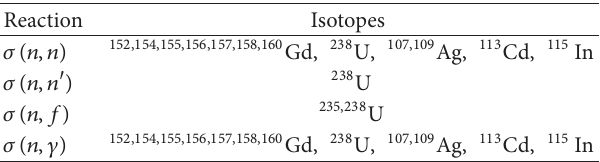
Table 1: Reaction cross sections perturbed using PERT cards in the MCNPX-2.7e